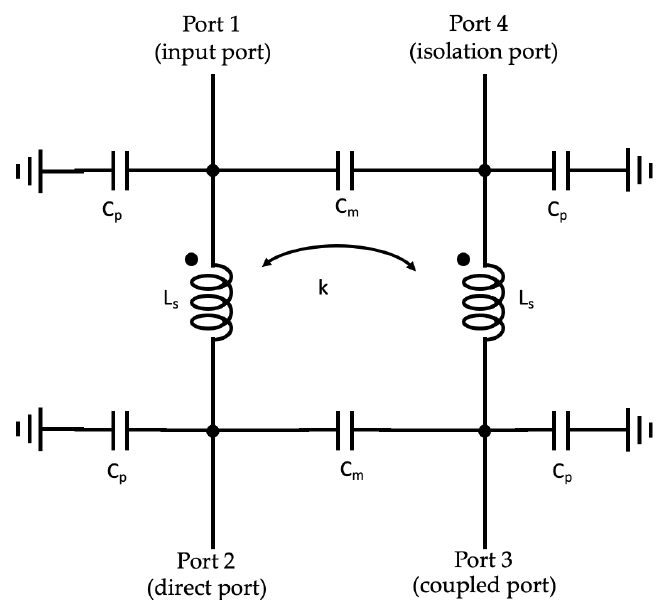
Figure 2. The equivalent circuit model of the parallel coupler; C m and C p are the parasitic capacitances between the two parallel lines and the parallel line to ground, respectively.